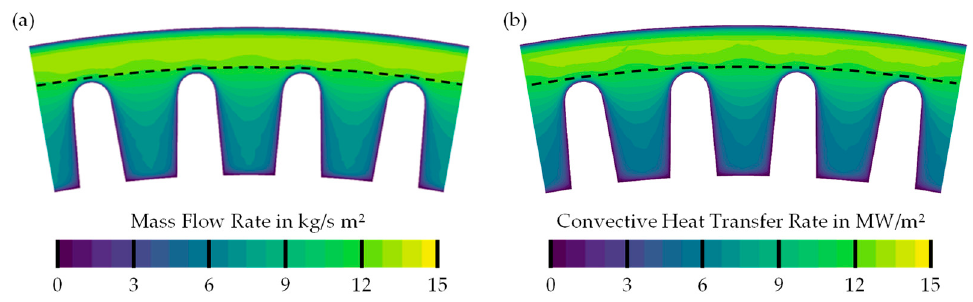
Figure 10. Mass Flow Rate ( a ) and convective heat transfer ( b ) on a radial cross-section at z = 340 mm for P = 160 kW, λ = 1.15 and T o = 1000 °C.